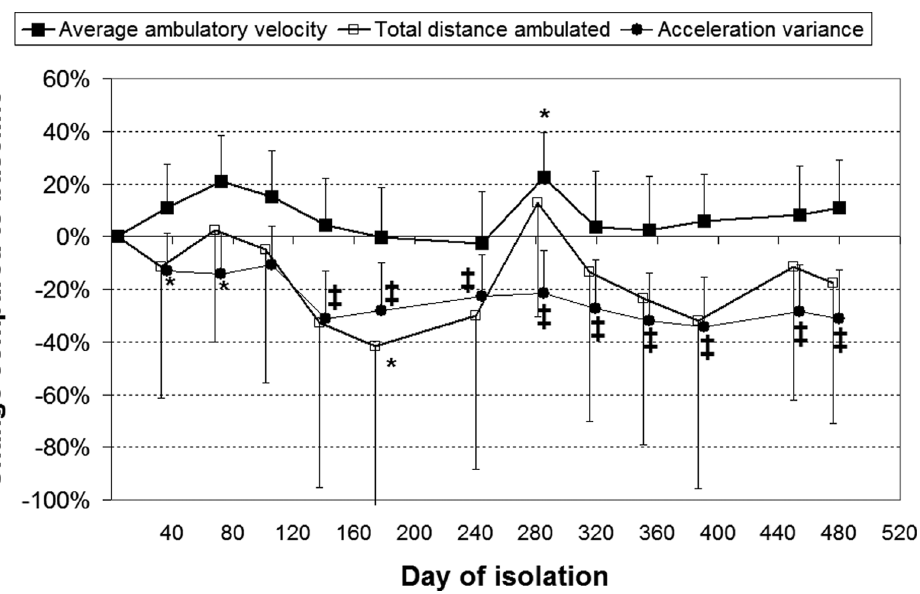
Figure 2. Physical activity during isolation. Values are mean (SD) percentage change compared to first measurement. *: p , 0.05; { : p , 0.01; { : p , 0.001 and give the significance of the change. The variables measured at the same time-points have been offset slightly. Average gait speed and distance walked were significantly increased when subjects were scheduled to perform running exercises (days 71–141, 285–354 and 451–520 of isolation; statistical analyses not shown).